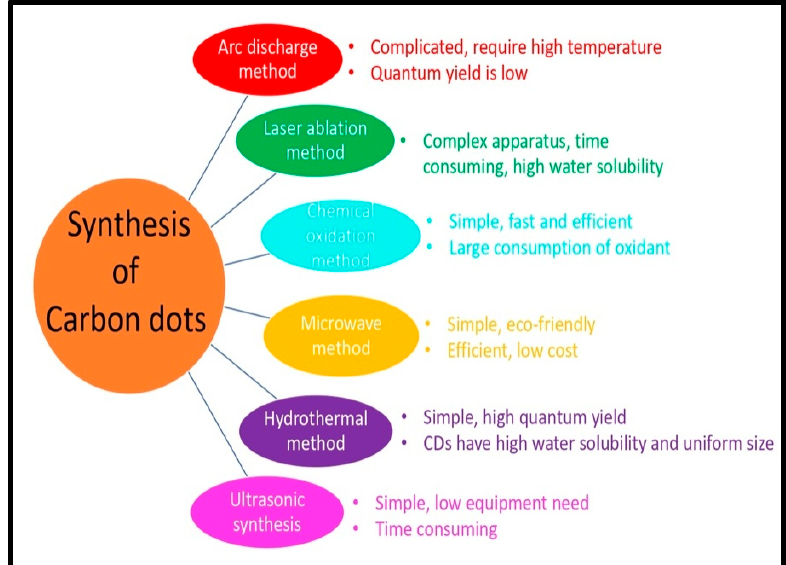
Figure 2. Different methods for synthesis of CQDs and GQDs and their distinctive features.